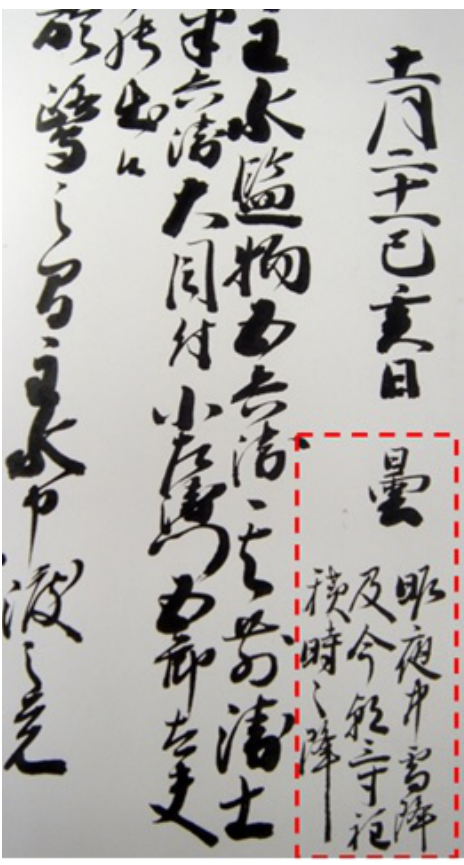
Figure 2. An example of daily weather records from the diary of the Hirosaki clan (for 5 January 1801) from the Hirosaki City Library collection. The weather information is shown in the area surrounded by red dashed lines.